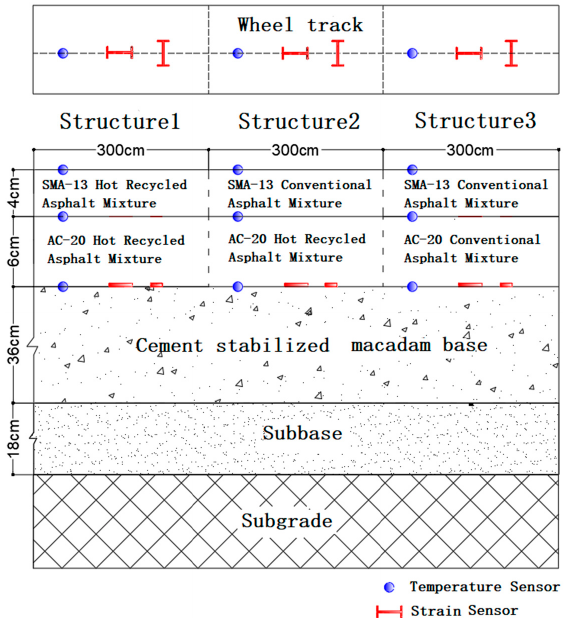
Figure 2. Schematic diagram of the test road sensor